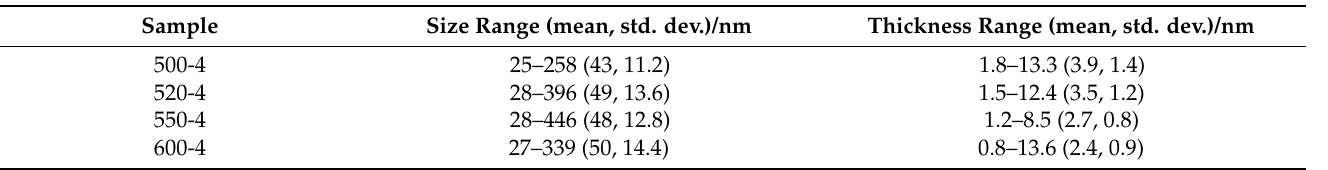
Table 1. Flake size and thickness distribution of PCN prepared at 500, 520, 550, and 600 ◦ C (500-4, 520-4, 550-4, and 600-4,